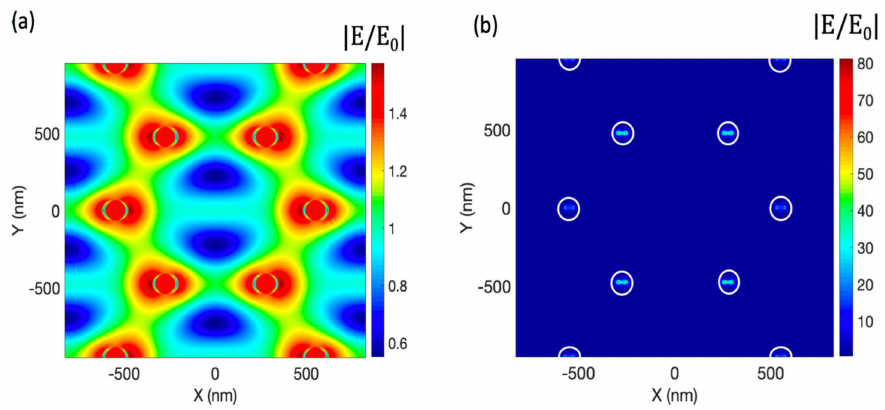
Figure 6. 758 nm electric field distribution at the top of cone array ( a ) without and ( b ) with